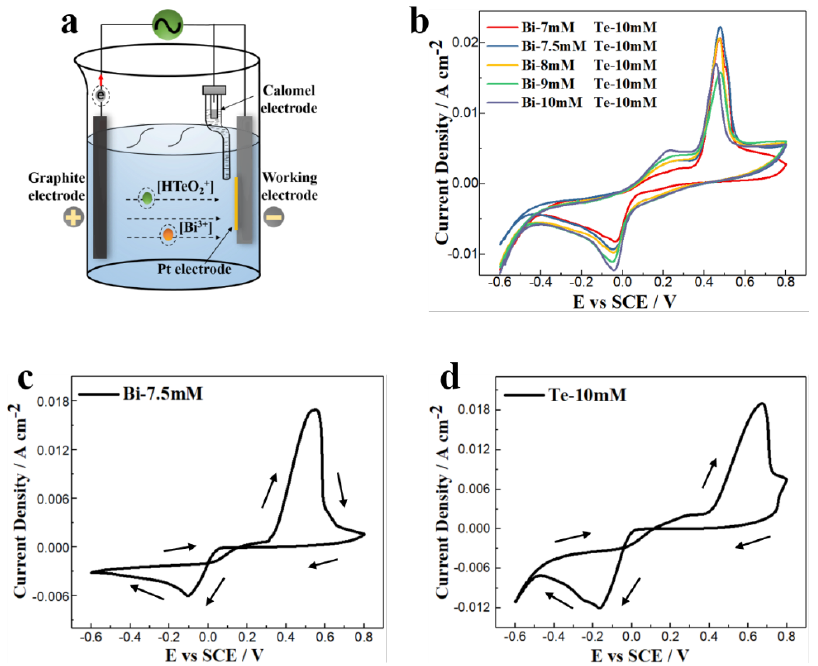
Figure 1. ( a ) The schematic of the three-electrode electrodeposition device. ( b ) Cyclic voltammetry curves of the electrolyte with a 10 mM Te concentration and 7 mM, 7.5 mM, 8 mM, 9 mM, and 10 mM Bi concentrations. ( c , d ) CV curves of the unitary Bi (7.5 mM) and unitary Te (10